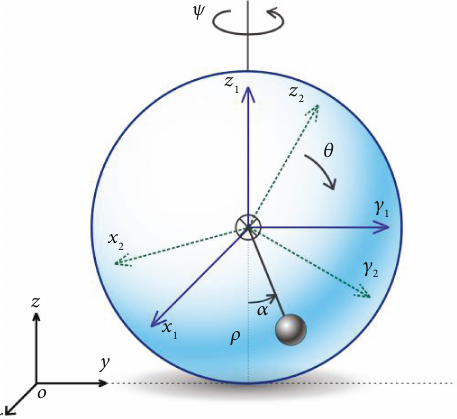
Figure 2: Reference frames and kinematic schemes of rotation around the transverse axis resulting in longitudinal motion.